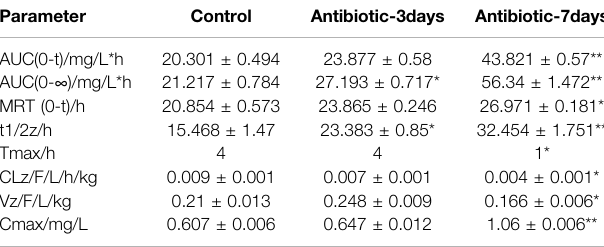
TABLE 2 | Comparison of the pharmacokinetic parameters of Warfarin (n = 3). Parameter